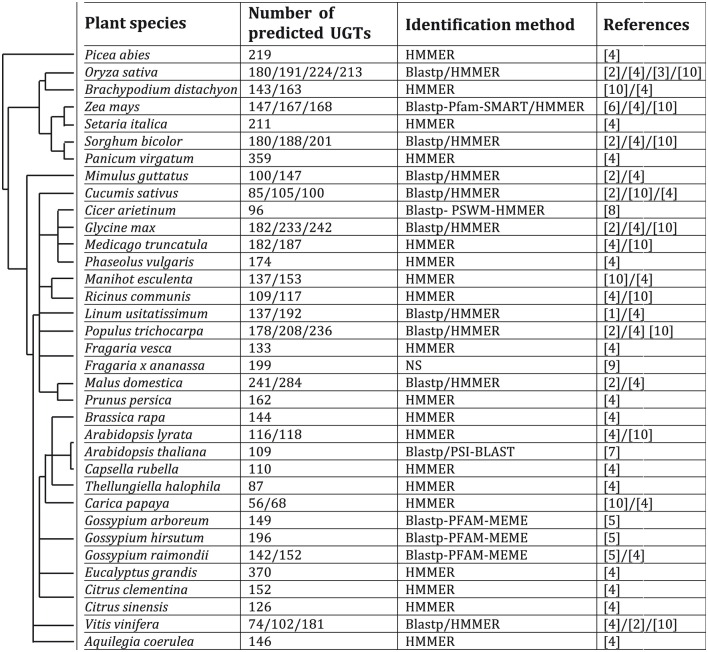
Predicted UGT enzymes in different higher plants. Species are arranged in an order based on taxonomic families. [1], Barvkar et al. (2012); [2], Caputi et al. (2012); [3], Cao et al. (2008); [4], Ekstrom et al. (2014); [5], Huang et al. (2015); [6], Li et al. (2014); [7], Ross et al. (2001); [8], Sharma et al. (2014); [9], Song et al. (2015); [10], Yonekura-Sakakibara and Hanada (2011).